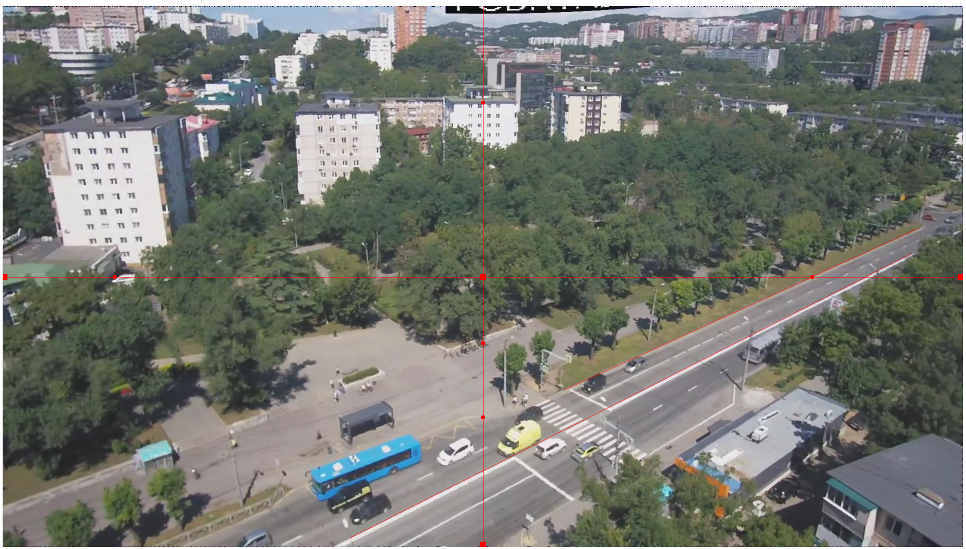
Figure 11. Cropped and interpolated part of image ˆ Φ